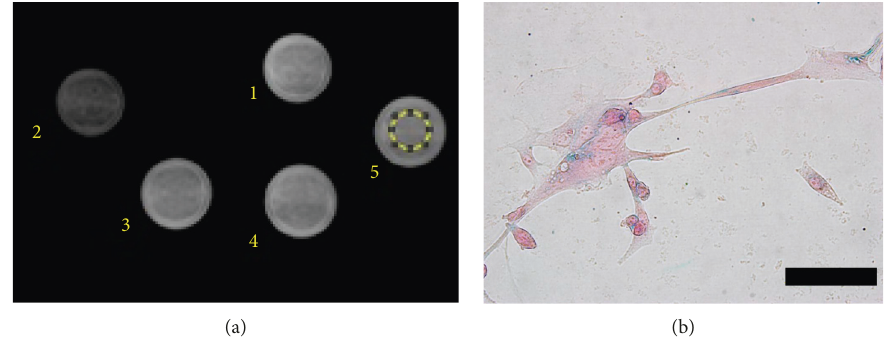
Figure 5: MMP-12-targeted probe is selectively cleaved by MMP-12 in vitro . (a) U87 glioma model MRI phantom showed lower intensity in the ROI (indicated by yellow circle) of (2) cells treated with probe only, compared to (3 and 4) cells treated with probe and MMP408, (5) untreated cells, and a (1) blank. (b) Microscopic observation of U87 cells stained with prussian blue, following incubation with the probe, shows iron-positive areas (scale bar � 100 μ